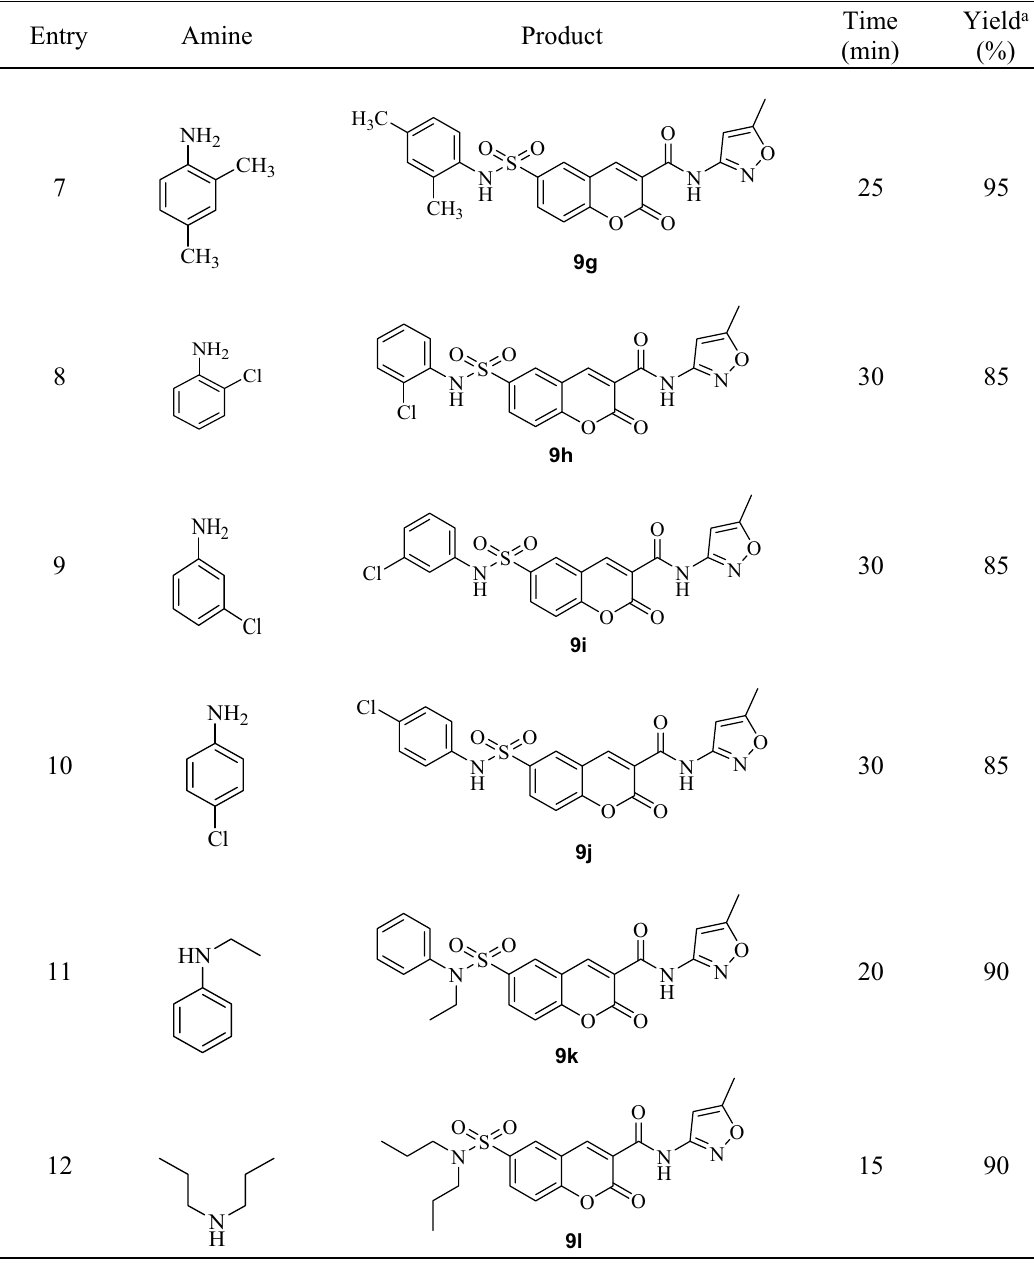
Table 2. Synthesis of coumarin sulfonamide isoxazol hybrids 9 a – l . a Isolated